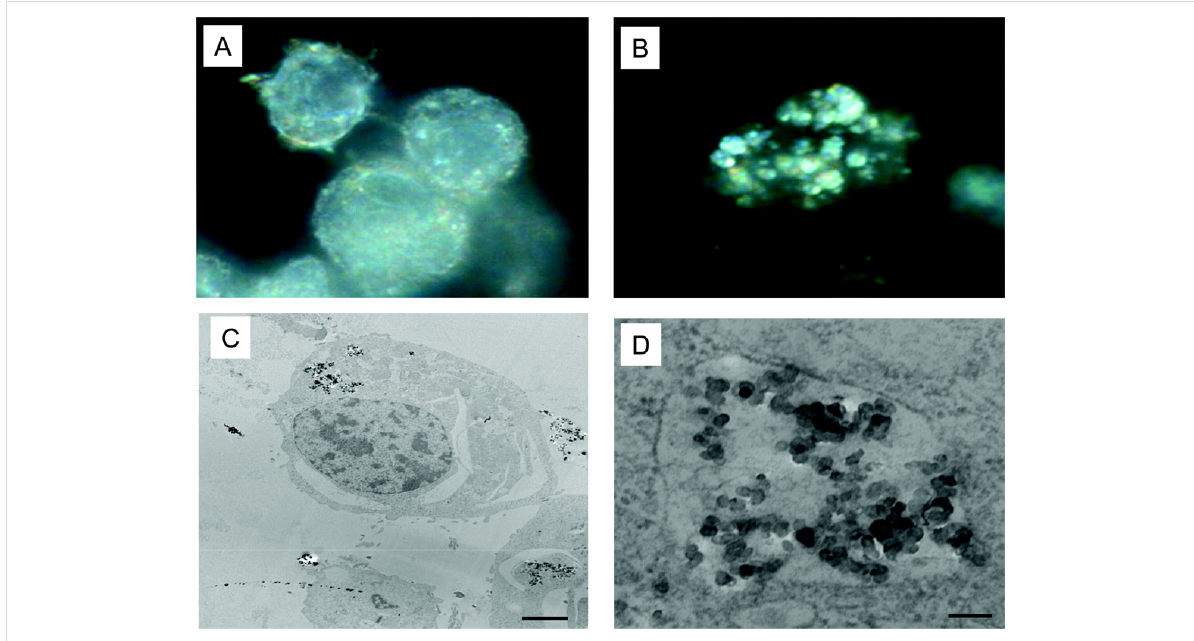
Figure 7: Examination of AgNP uptake by macrophages. (A) Control cells and (B) cells treated with 25 µg/mL of 30 nm AgNPs. (C) TEM micrograph of cells treated with 25 µg/mL of 55 nm AgNPs after 24 h of incubation and (D) magnified micrograph of the cell in (C) showing the accumulated AgNPs. Reprinted with permission from [102], Copyright 2008 American Chemical